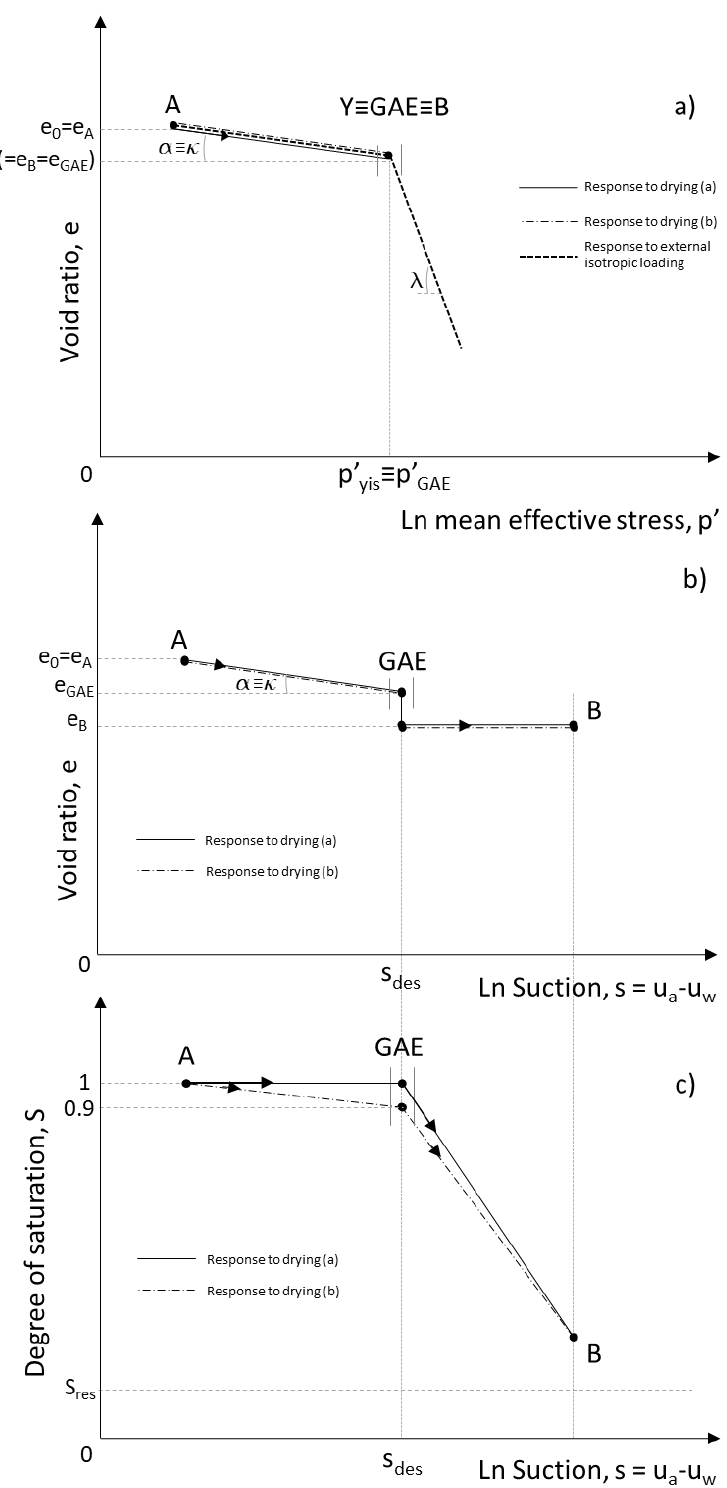
Figure 5. Schematic outline of the response of overconsolidated clays to free drying, according to the framework proposed by Cafaro and Cotecchia [69]: ( a ) void ratio — mean effective stress path of the clay under either isotropic compression, or free-drying; ( b ‒ c ) Cafaro and Cotecchia [69] model. The dashed line represents the response to external loading; the continuous thin line represents the response to drying when S = 1 for s < s des ; the dash and dot line represents the response to drying when 0.9 < S < 1 for s < s des .